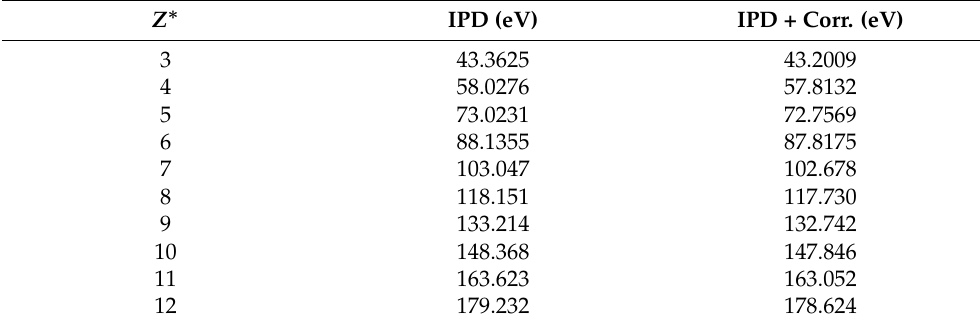
Table 2. Correction to the IPD due to Equation (18) for an Al plasma at T = 180 eV and ρ = 2.7 g/cm 3 (conditions of Ciricosta’s experiment [30]).